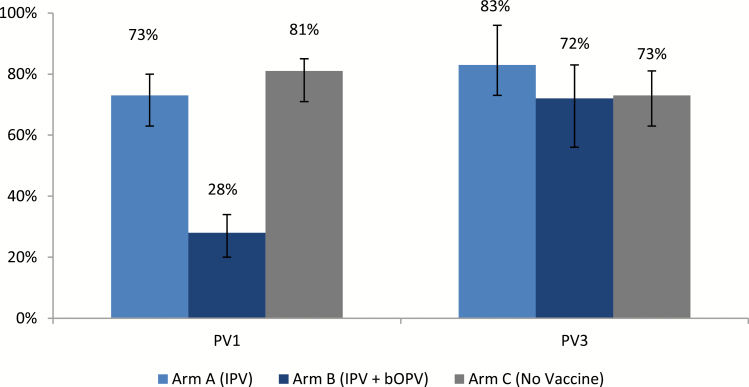
Excretion of PV1 and PV3 following challenge with tOPV (at any point after the tOPV challenge). Abbreviations: bOPV, bivalent oral poliovirus vaccine; IPV, inactivated poliovirus vaccine; PV1, polyvirus type 2; PV3, polyvirus type 3; tOPV, trivalent oral poliovirus vaccine.